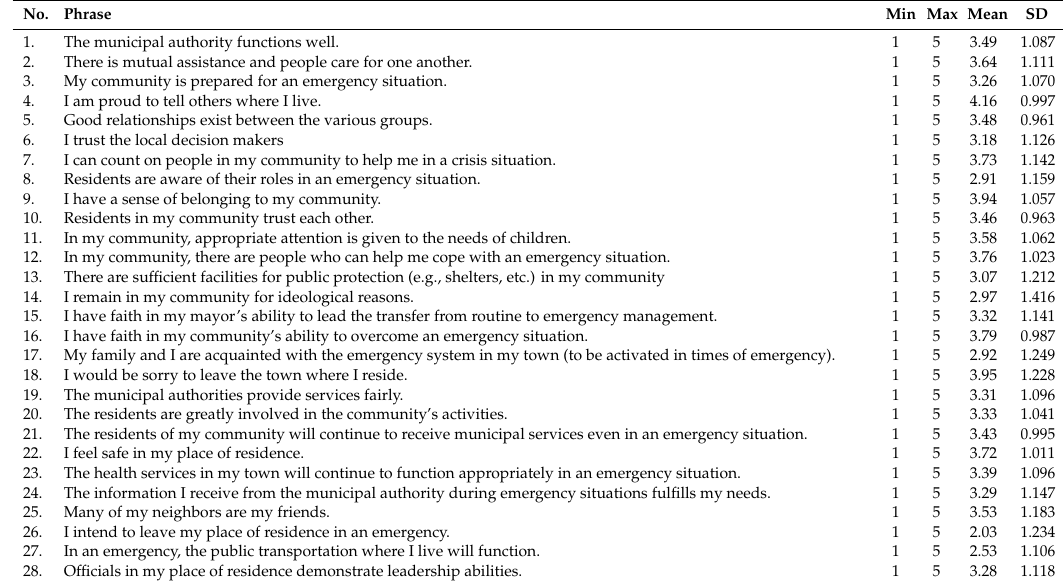
Table A1. Distribution of scores for individual CCRAM items.